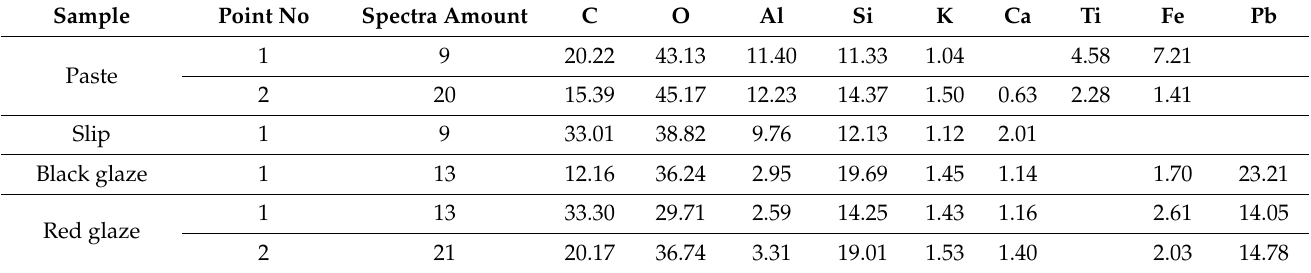
Table 1. EDS data on the major chemical elemental composition of the paste, slip, black glaze, and red glaze tested on a separate fragment of the figurine (mean